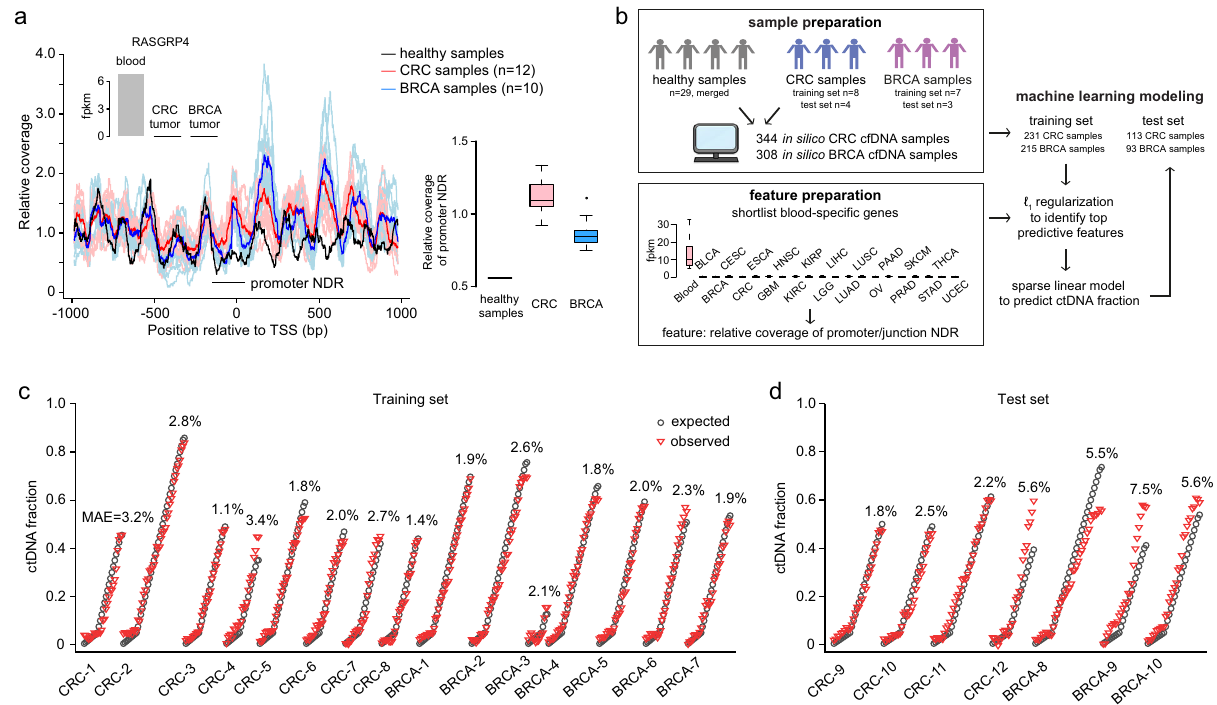
Fig. 5 Estimation of ctDNA burden across two distinct cancer types. a cfDNA relative coverage across the promoter region of the blood-speci fi c gene, RASGRP4 (ENST00000615340). Red and blue curves show the mean of the coverages from plasma samples from CRC and BRCA patients, respectively. b Schematic showing how the ctDNA content prediction model across CRC and BRCA cfDNA samples was developed. c , d Comparison of expected (in silico simulation) and observed ctDNA fractions across CRC and BRCA cfDNA samples in the c training and d test set, respectively. The mean absolute error is listed for each sample. Boxplots represent the median as centreline, the interquartile range (IQR) as bounds of box, and the lower quartile – 1.5 IQR and the upper quartile + 1.5 IQR as